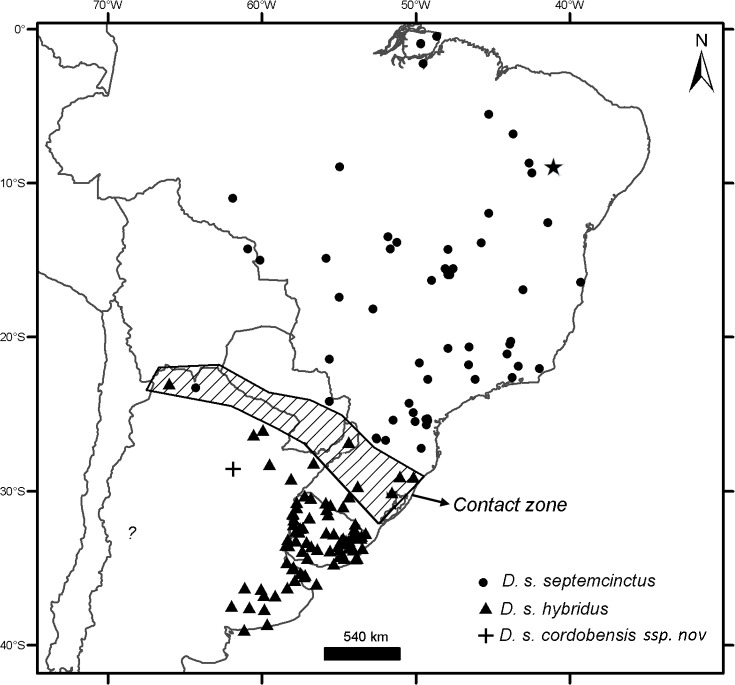
Localities recorded for Dasypus septemcinctus Linnaeus, 1758, showing records for the three subspecies and the putative contact zone between D. s. septemcinctus and D. s. hybridus.Star represents the type locality for the nominate subspecies (D. s. septemcinctus). Question mark: doubtful record from Mendoza.